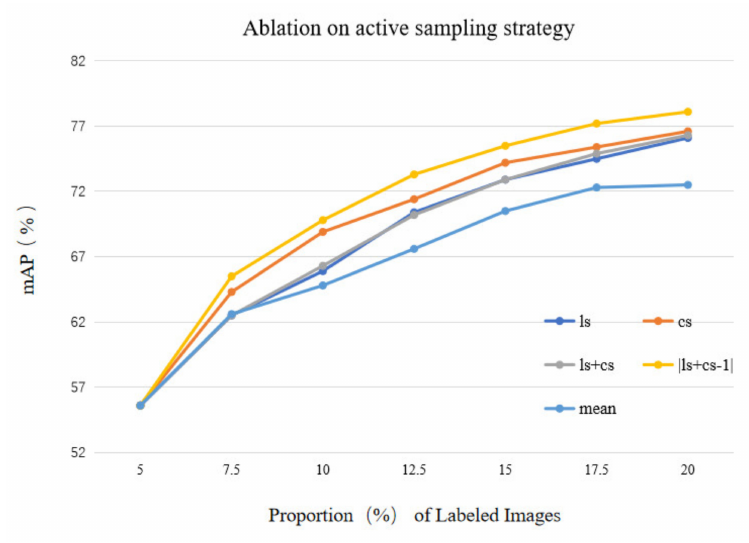
Figure 5. Ablation study on different active sampling strategies: ls only, cs only, ls + cs, |ls + cs − 1|, and mean strategy,